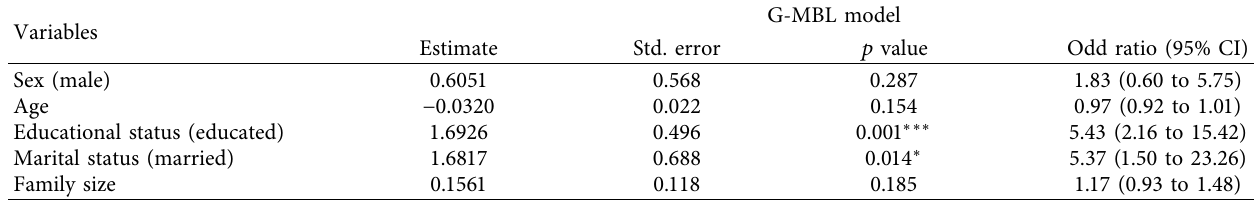
Table 2: Estimates and odds ratio of factors affecting controlled mating systems at Gechi district.